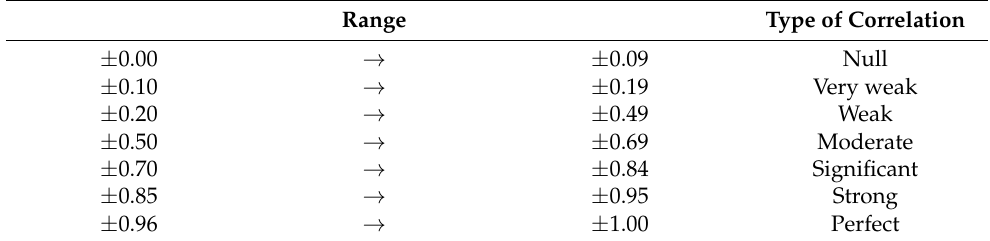
Figure 3. Correlation matrix for predictability indices for the time series made up of days with Santa Ana winds. Table 7. Ranges of correlation